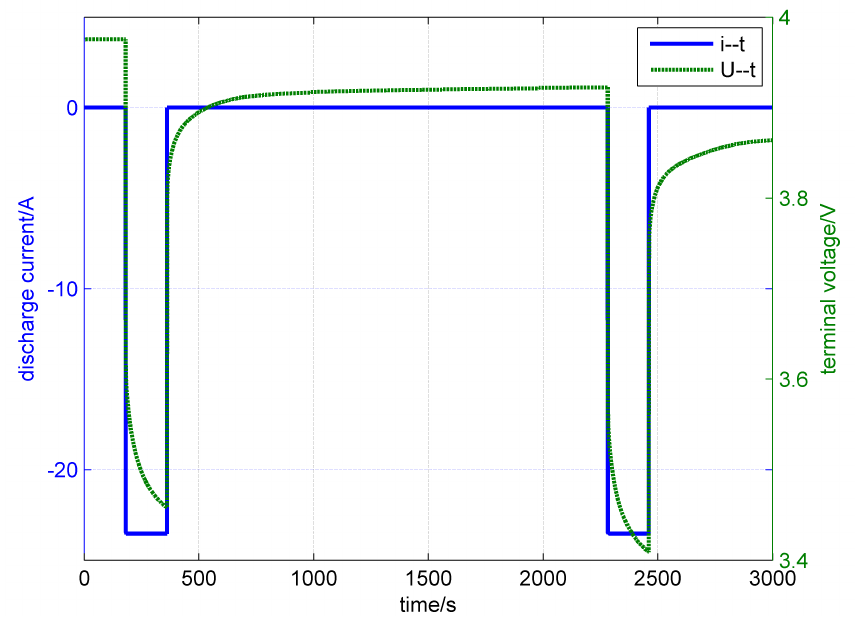
Figure 3. The part of the pulse characterization